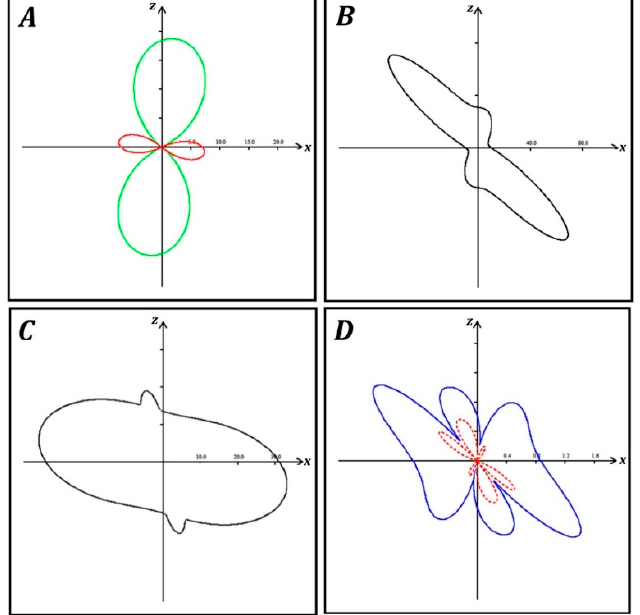
Figure 4. Two-dimensional projections on the xz plane of the tridimensional representations of the elastic properties of copper squarate as a function of the orientation of the applied stress: ( A ) Com- pressibility; ( B ) Young modulus; ( C ) Maximum shear modulus; ( D ) Maximum (blue) and minimum (red) Poisson’s ratios. The labels of the marks in the vertical axis are exactly the same as those of the horizontal one. In the plots, negative values are displayed in red.